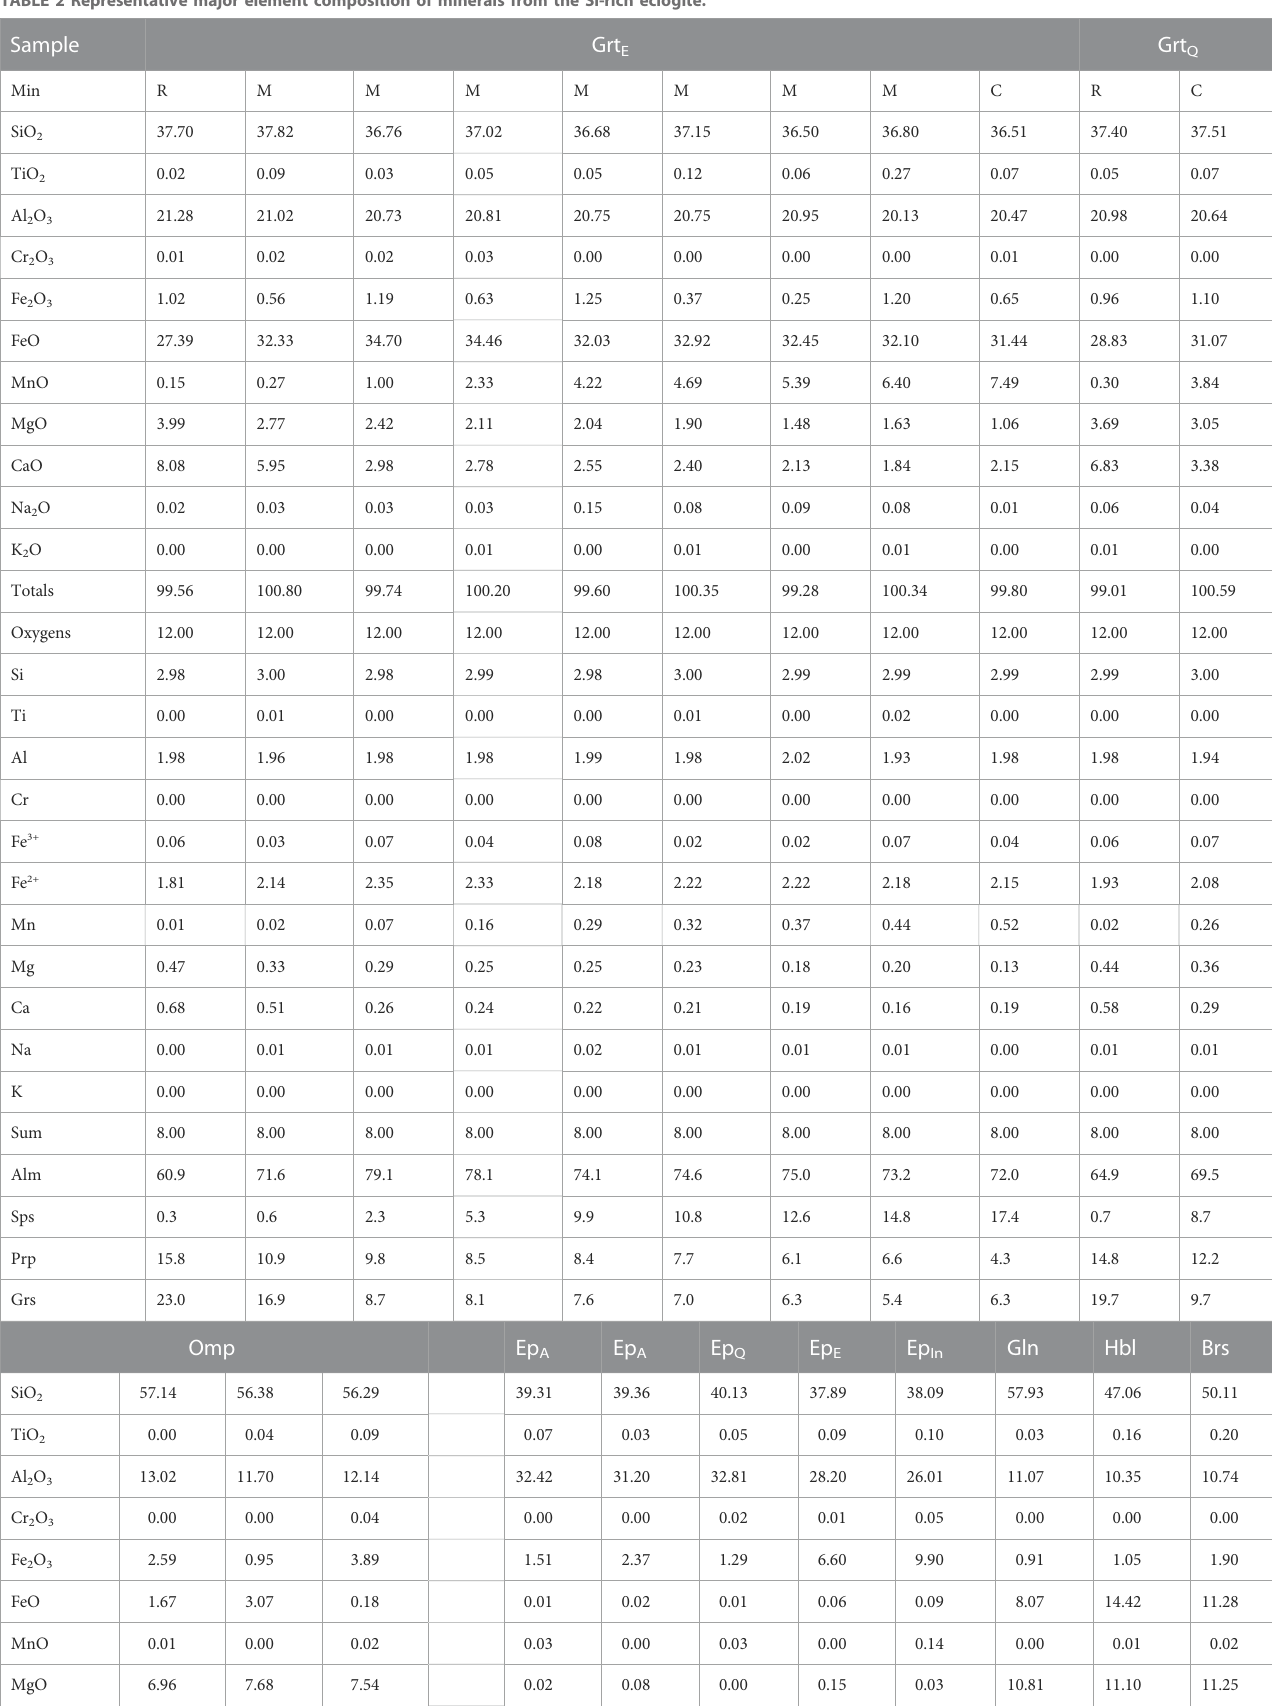
TABLE 2 Representative major element composition of minerals from the Si-rich eclogite. Sample Grt E Grt